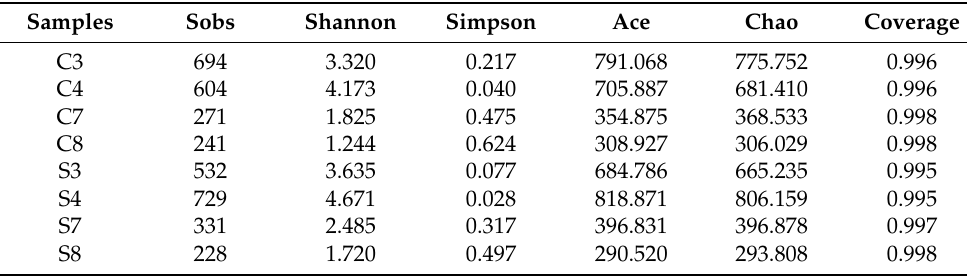
Table 2. Microbial community richness and diversity